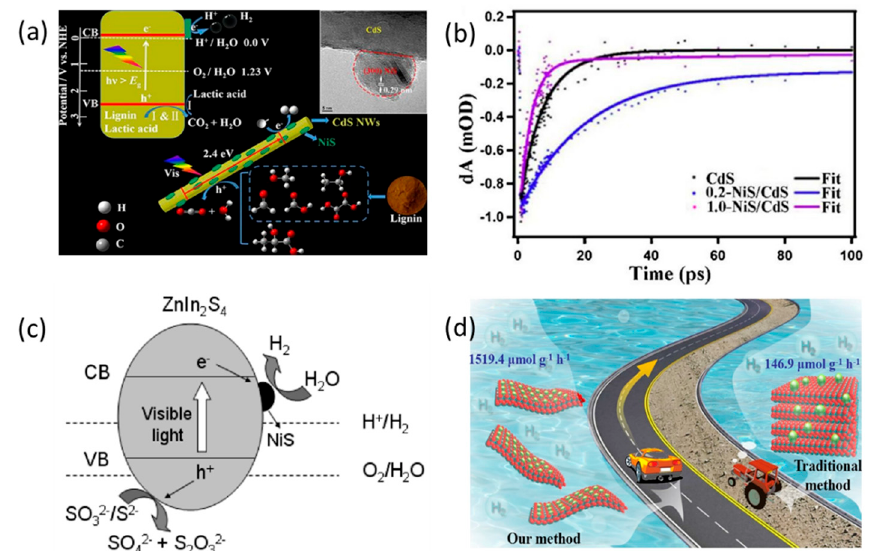
Figure 6. ( a ) Schematic illustration of the photocatalytic hydrogen production by NiS / CdS composites; ( b ) normalized ultrafast transient bleach decay of CdS nanowire, 0.2-NiS / CdS and 1.0-NiS / CdS. Adapted with permission from [30]; ( c ) schematic illustration of proposed mechanism over NiS / ZnIn 2 S 4 photocatalysts. Adapted with permission from [31]; ( d ) comparison of NiS / HNb 3 O 8 photocatalysts synthesized by electrostatic adsorption method and traditional method. Adapted with permission from [32].